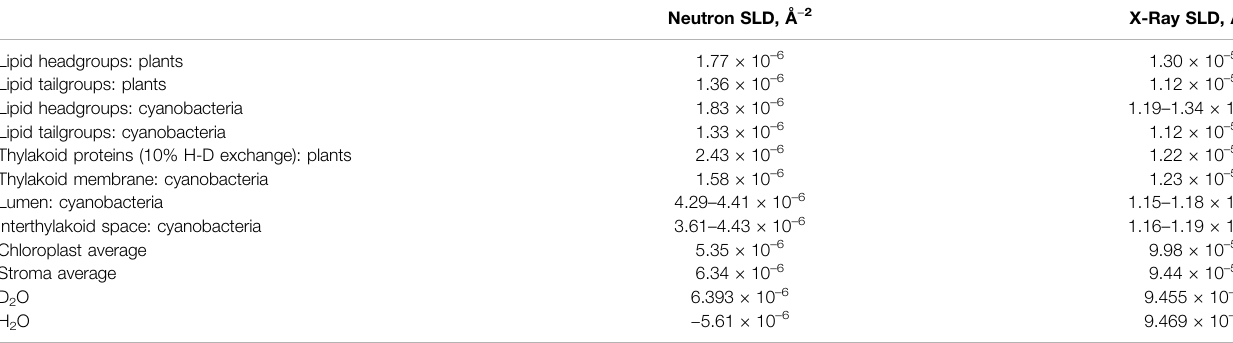
TABLE 2 | Scattering length densities of thylakoid components [taken from Jakubauskas (2016) and Jakubauskas et al. (2019)].